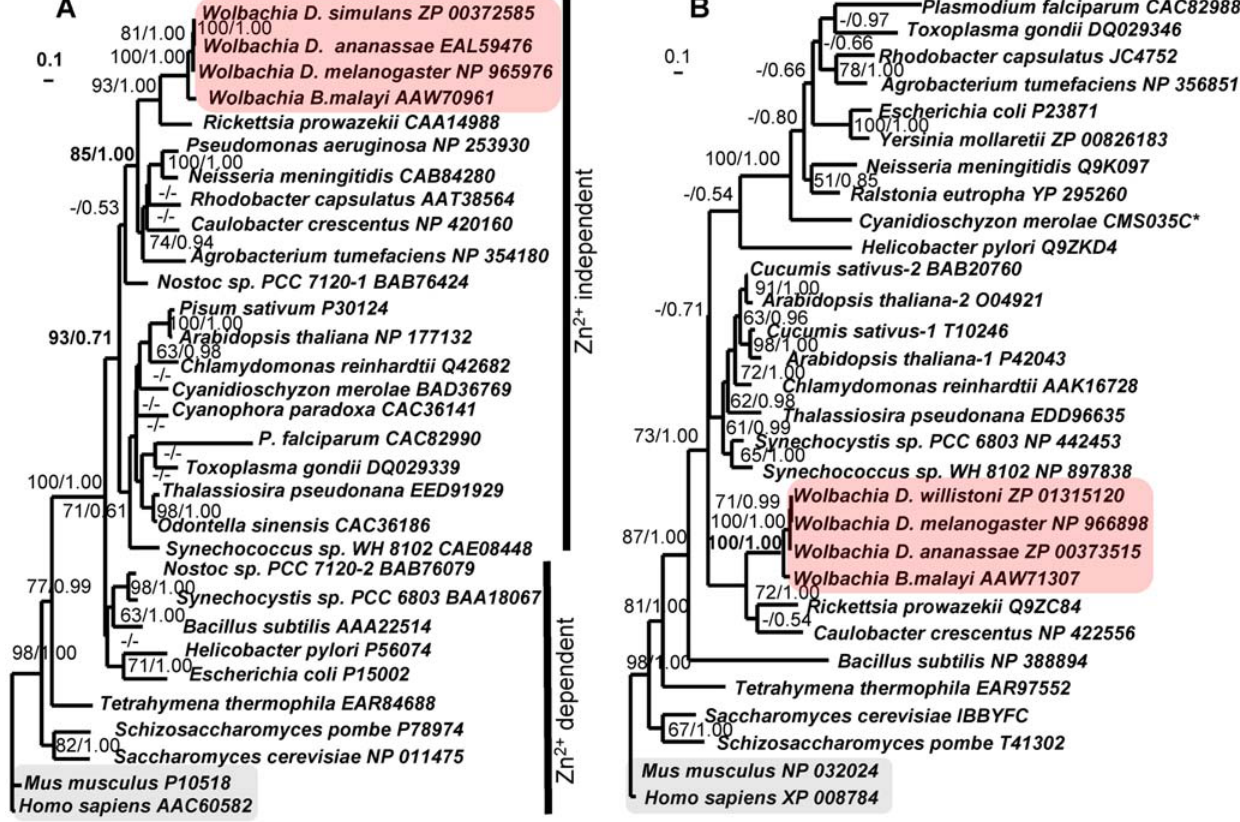
Figure 2. Gene phylogeny of ALAD and FC. A) ALAD, B) FC. The scaled Maximum likelihood (ML) consensus trees were inferred by ProML program of PHYLIP 3.65 package [27]. Two methods – Bayesian inference (BI) and ML analyses were used in gene phylogeny reconstruction and yielded similar tree topologies (details see Materials and Methods). The supporting values shown at nodes were obtained from ML and BI analyses, respectively and the values below 50% indicated by hyphens. The branch length scale shown below ML tree represents estimated substitutions per site. Available GenBank accession numbers follow the corresponding sequences. The asterisk indicates sequences retrieved from the organism’s genome data; details are listed in the Text